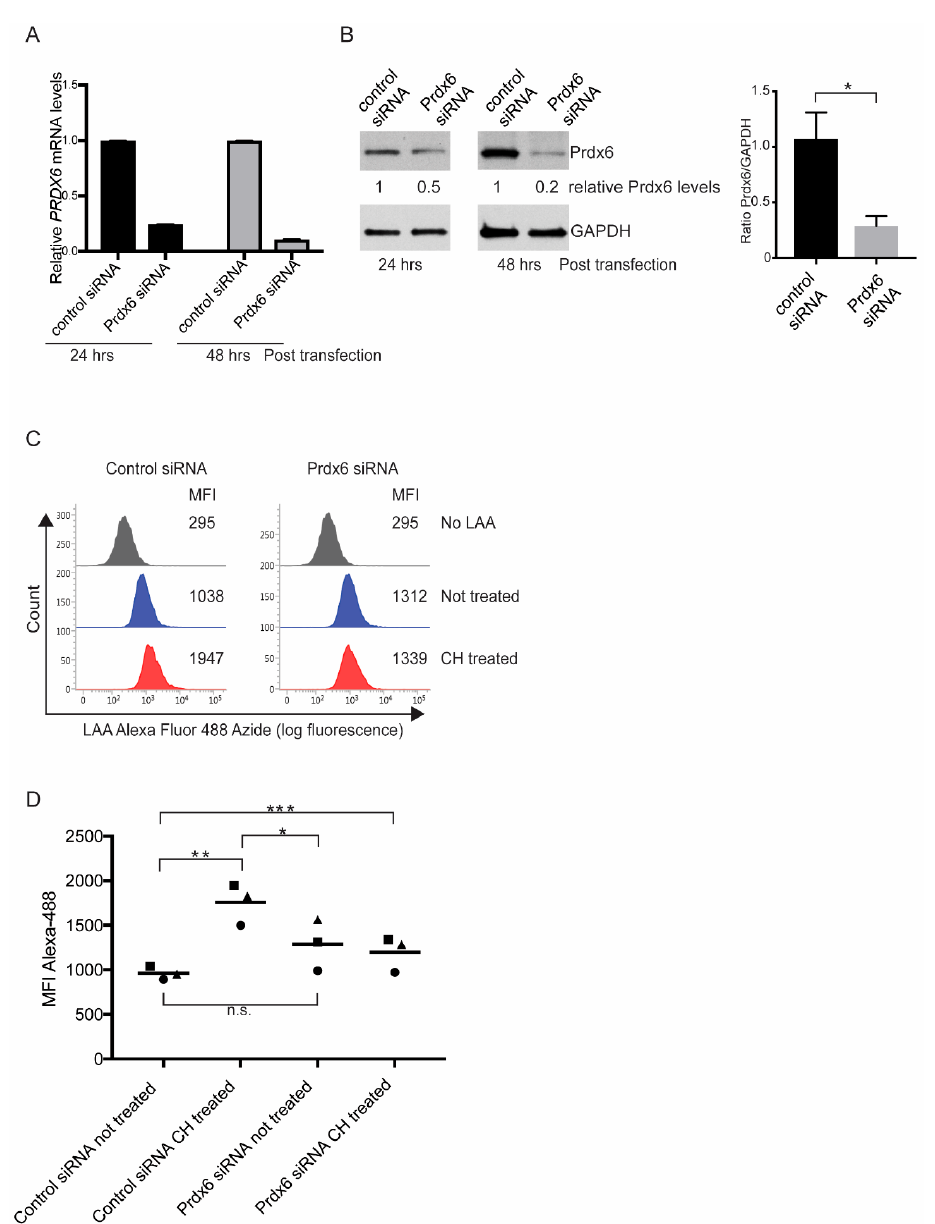
Figure 3. Targeted knockdown of Prdx6 in CEnCs reveals a role for Prdx6 in regulating lipid peroxidation. ( A ) Prdx6 mRNA levels were determined by qPCR analysis. Expression levels are shown relative to control siRNA treated B4G12 CEnCs and normalized to GAPDH. ( B ) Representative western blot analysis of aliquots of siRNA-transfected B4G12 CEnCs probed with anti-Prdx6 antibodies. Protein levels were quantitated relative to GAPDH and normalised to control siRNA. Data also expressed as mean ± SEM ( n = 6). * p -value (<0.05) was determined by student t -test. ( C ) Lipid peroxidation was measured in B4G12 CEnCs incubated with linoleamide alkyne (LAA) in the presence (cumene hydroperoxide (CH) treated) or absence of CH (not treated). B4G12 CEnCs incubated in the absence of LAA served as negative controls. ( D ) Data are expressed as mean fluorescence intensity (MFI) from three independent experiments. Two-way ANOVA with multiple comparisons was used to test statistical significance. Asterix (*) indicates statistical significance; * p < 0.05, ** p < 0.005, *** p < 0.01, n.s.: no significant